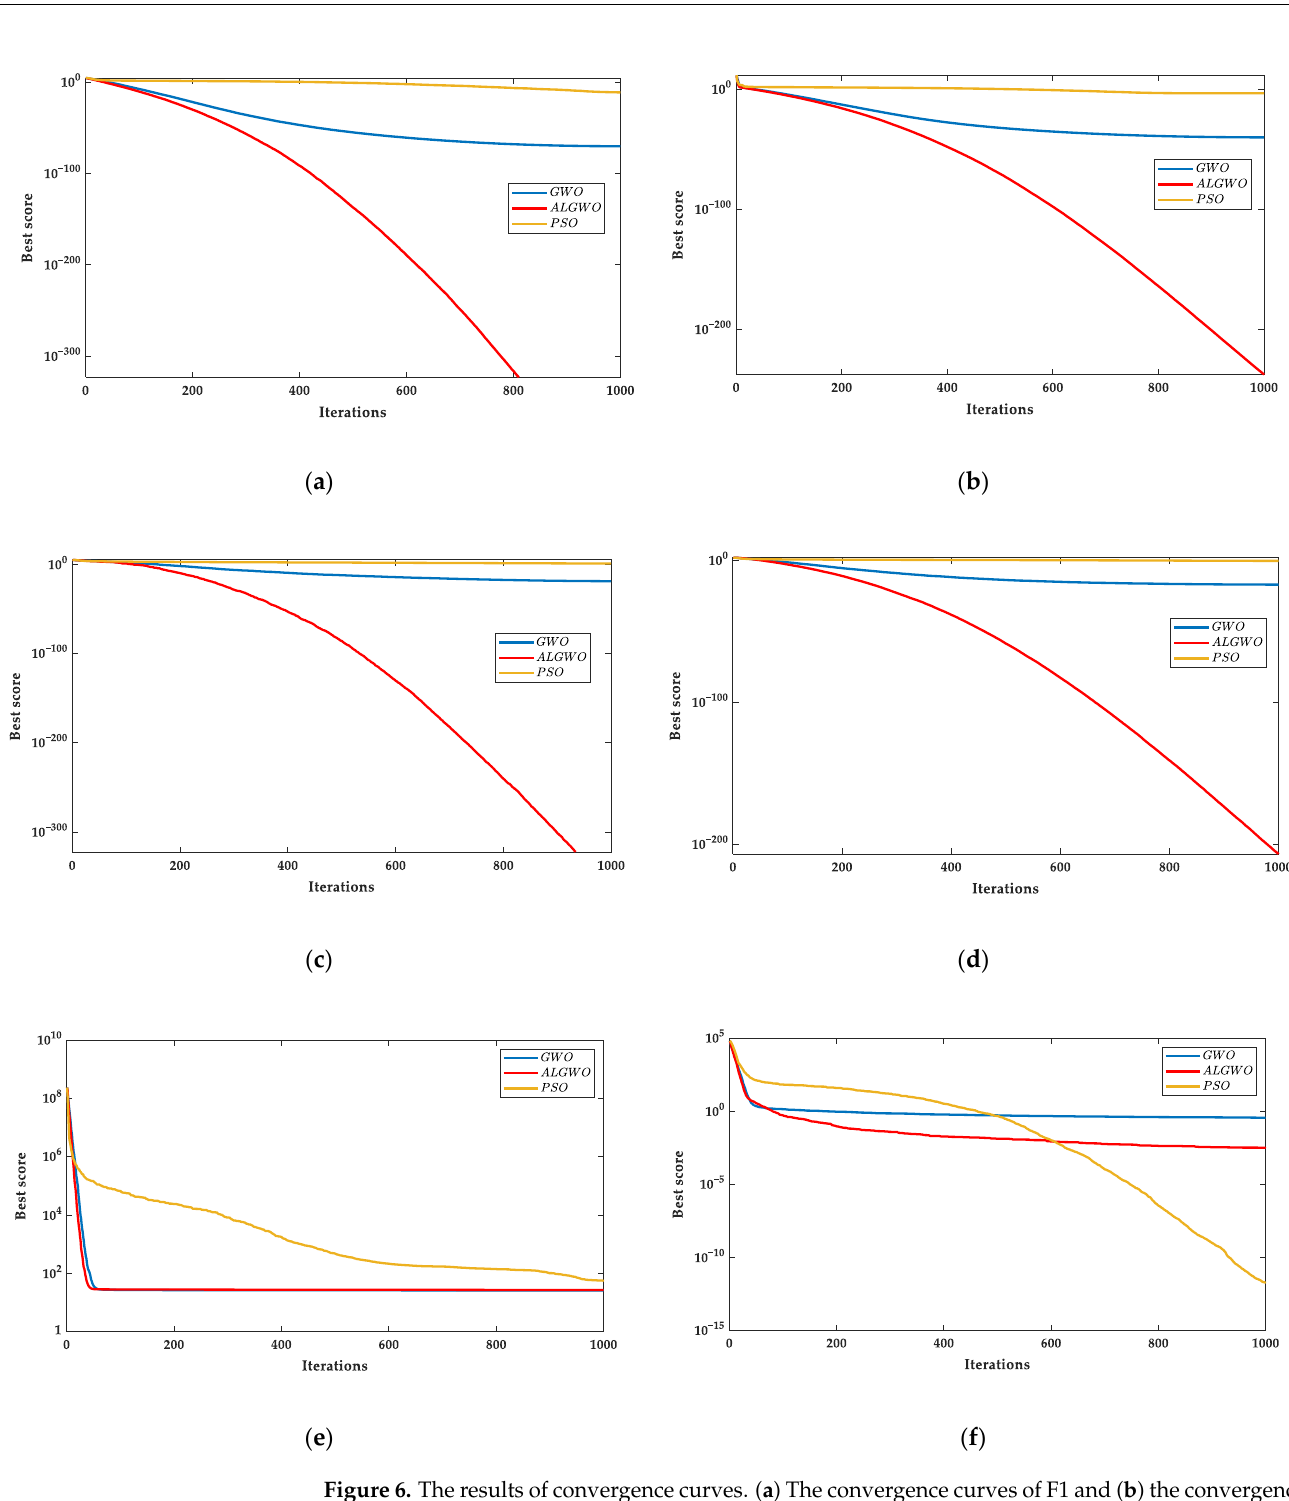
Figure 6. The results of convergence curves. ( a ) The convergence curves of F1 and ( b ) the convergence curves of F2 and ( c ) the convergence curves of F3 and ( d ) the convergence curves of F4 and ( e ) the convergence curves of F5 and ( f ) the convergence curves of F6.